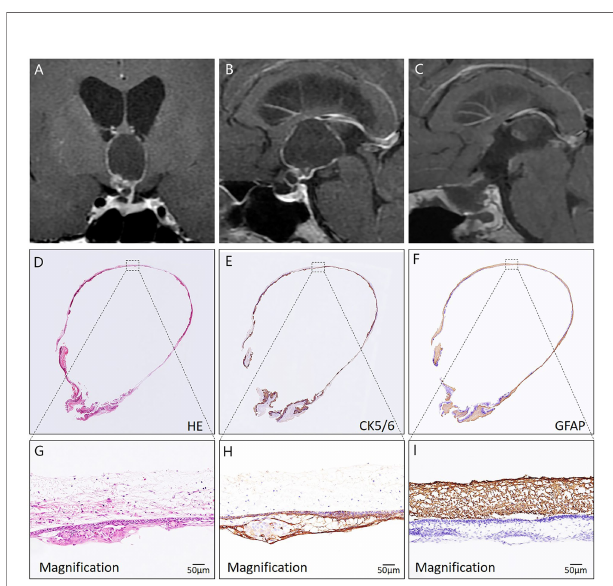
FIGURE 5 | Histological assessment of a CP with predominantly ventricular involvement using HE and immunohistochemical staining. In (A, B) , preoperative coronal and sagittal MRI reveals that a cystic-solid mass mainly develops into the compartment of the third ventricle. In (C) , postoperative MRI demonstrates complete tumor removal. In (D – I) , the pathological image of the tumor specimen indicates that the whole tumor (CK5/6 positive) was resected along a dense band of gliosis (GFAP